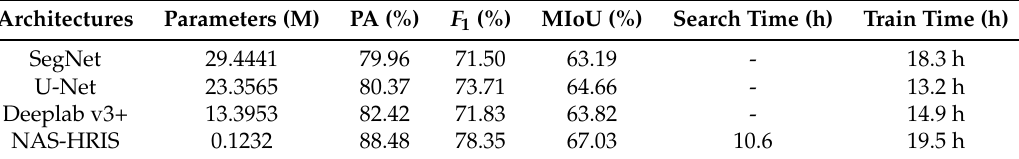
Table 2. Testing result on GID_Dataset